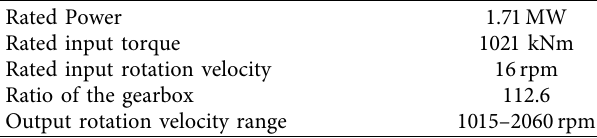
Table 1: Basic technical parameters of wind turbine.